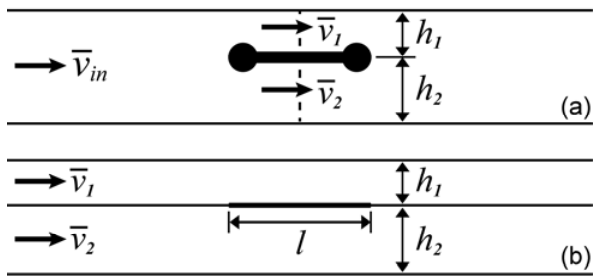
Figure 3. ( a ) Schematic of the suspended optical waveguide sensor in the flow cell (not to scale). h and h are defined as the distances from the mid-plane of the sensor to the top 1 2 and (cid:1874) are the average flow velocities through the and bottom surfaces of the channel, (cid:1874) (cid:2869) (cid:2870) regions above and below the sensor, and l is the length of the sensor in the direction of flow; ( b ) Schematic of an analogous hypothetical system consisting of two identical surface-bound flat planar sensors of length l , located in two channels of height h and h 1 2 respectively, through which fluid flows with average velocity (cid:1874) and (cid:1874) respectively. Our (cid:2869) (cid:2870) approach is built on the intuition that the binding behavior of the suspended sensor might be reasonably approximated by the sum of the binding behaviors of these two flat planar sensors, which represent its upper and lower